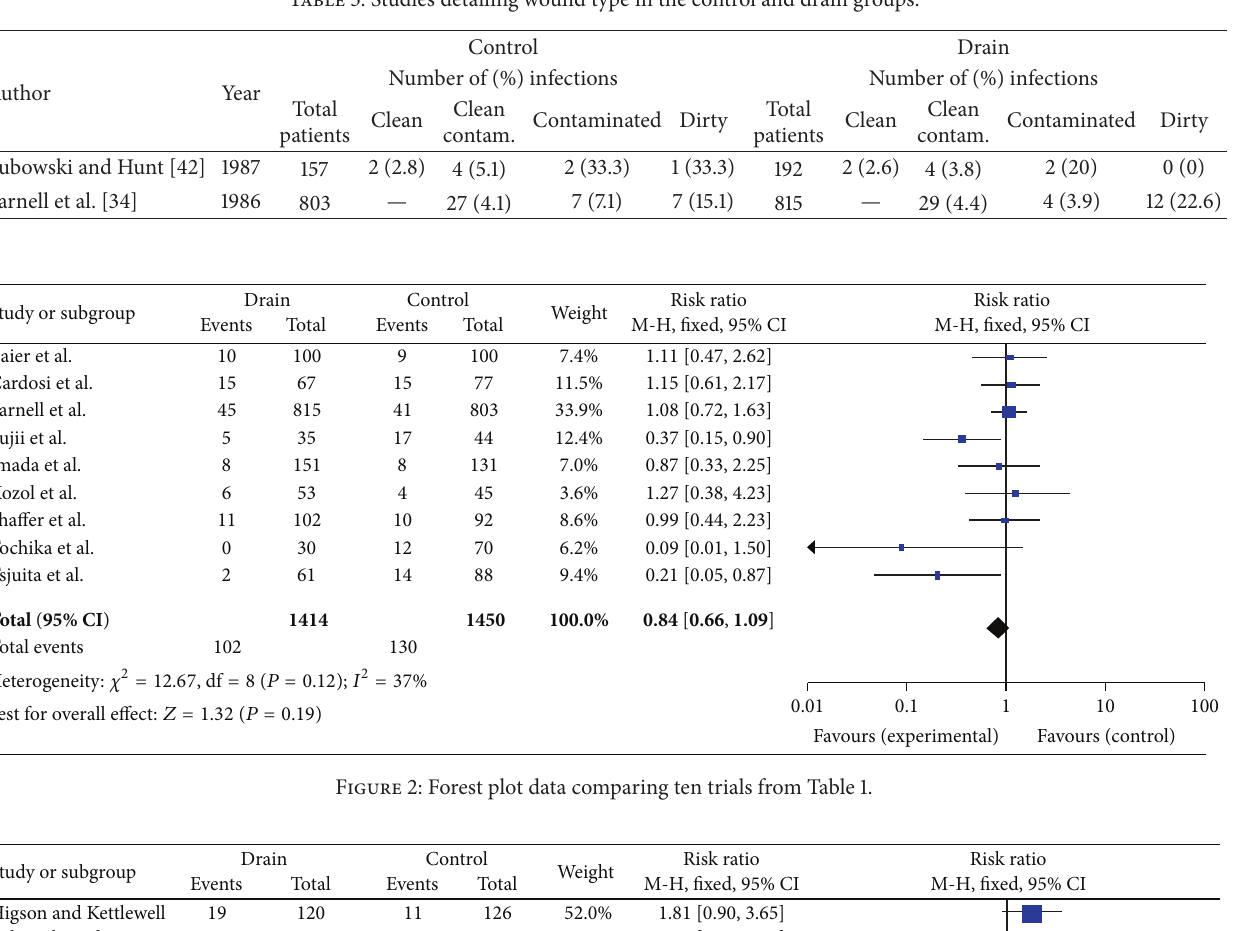
Table 3: Studies detailing wound type in the control and drain groups.